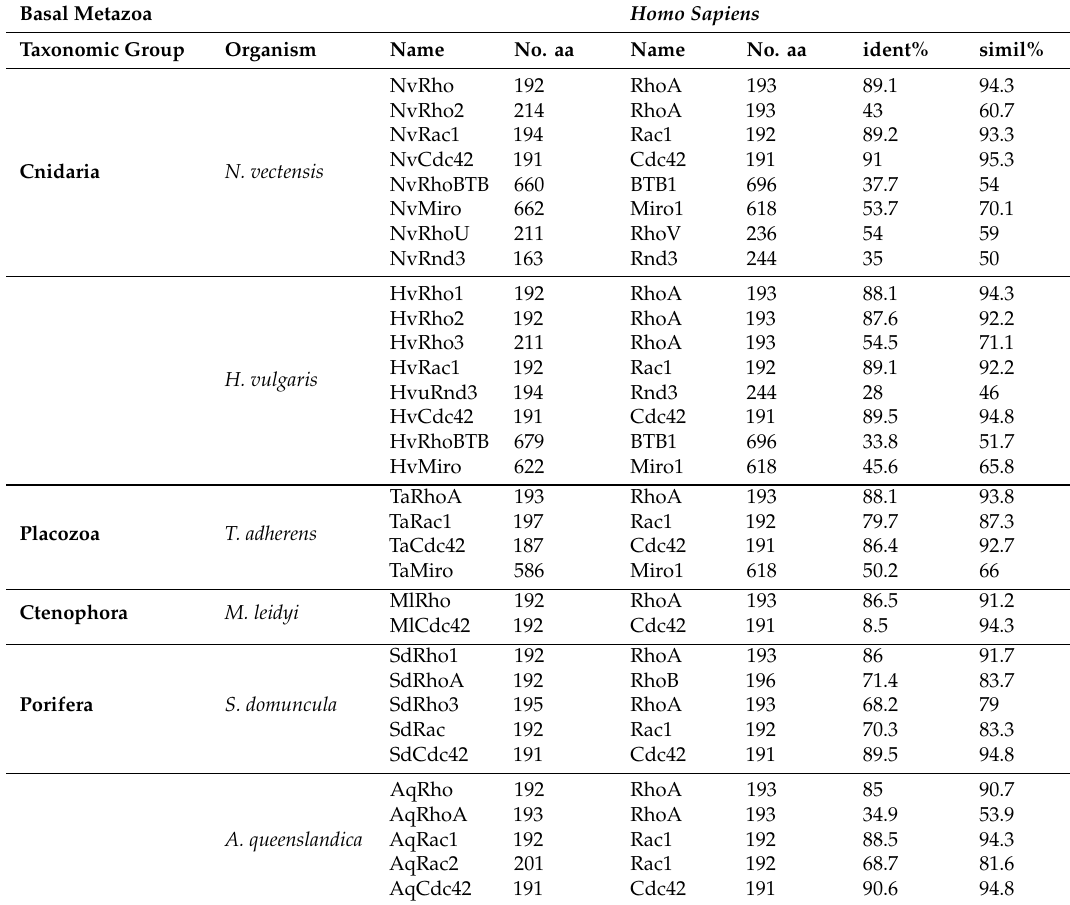
Table 2. Rho GTPases from basal Metazoa: comparison with most related human proteins. Basal Metazoa Homo